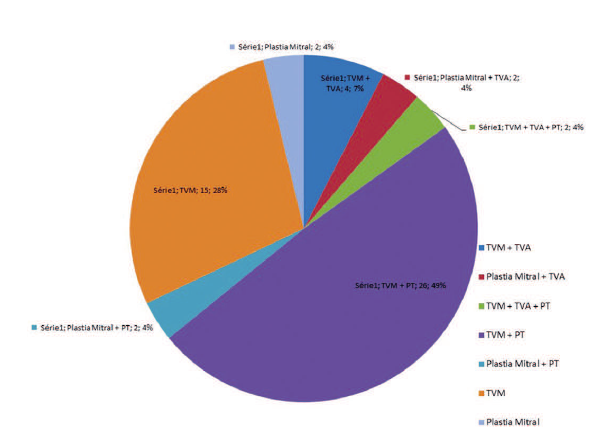
Fig. 2 - Tipos de lesões realizadas. AE = átrio